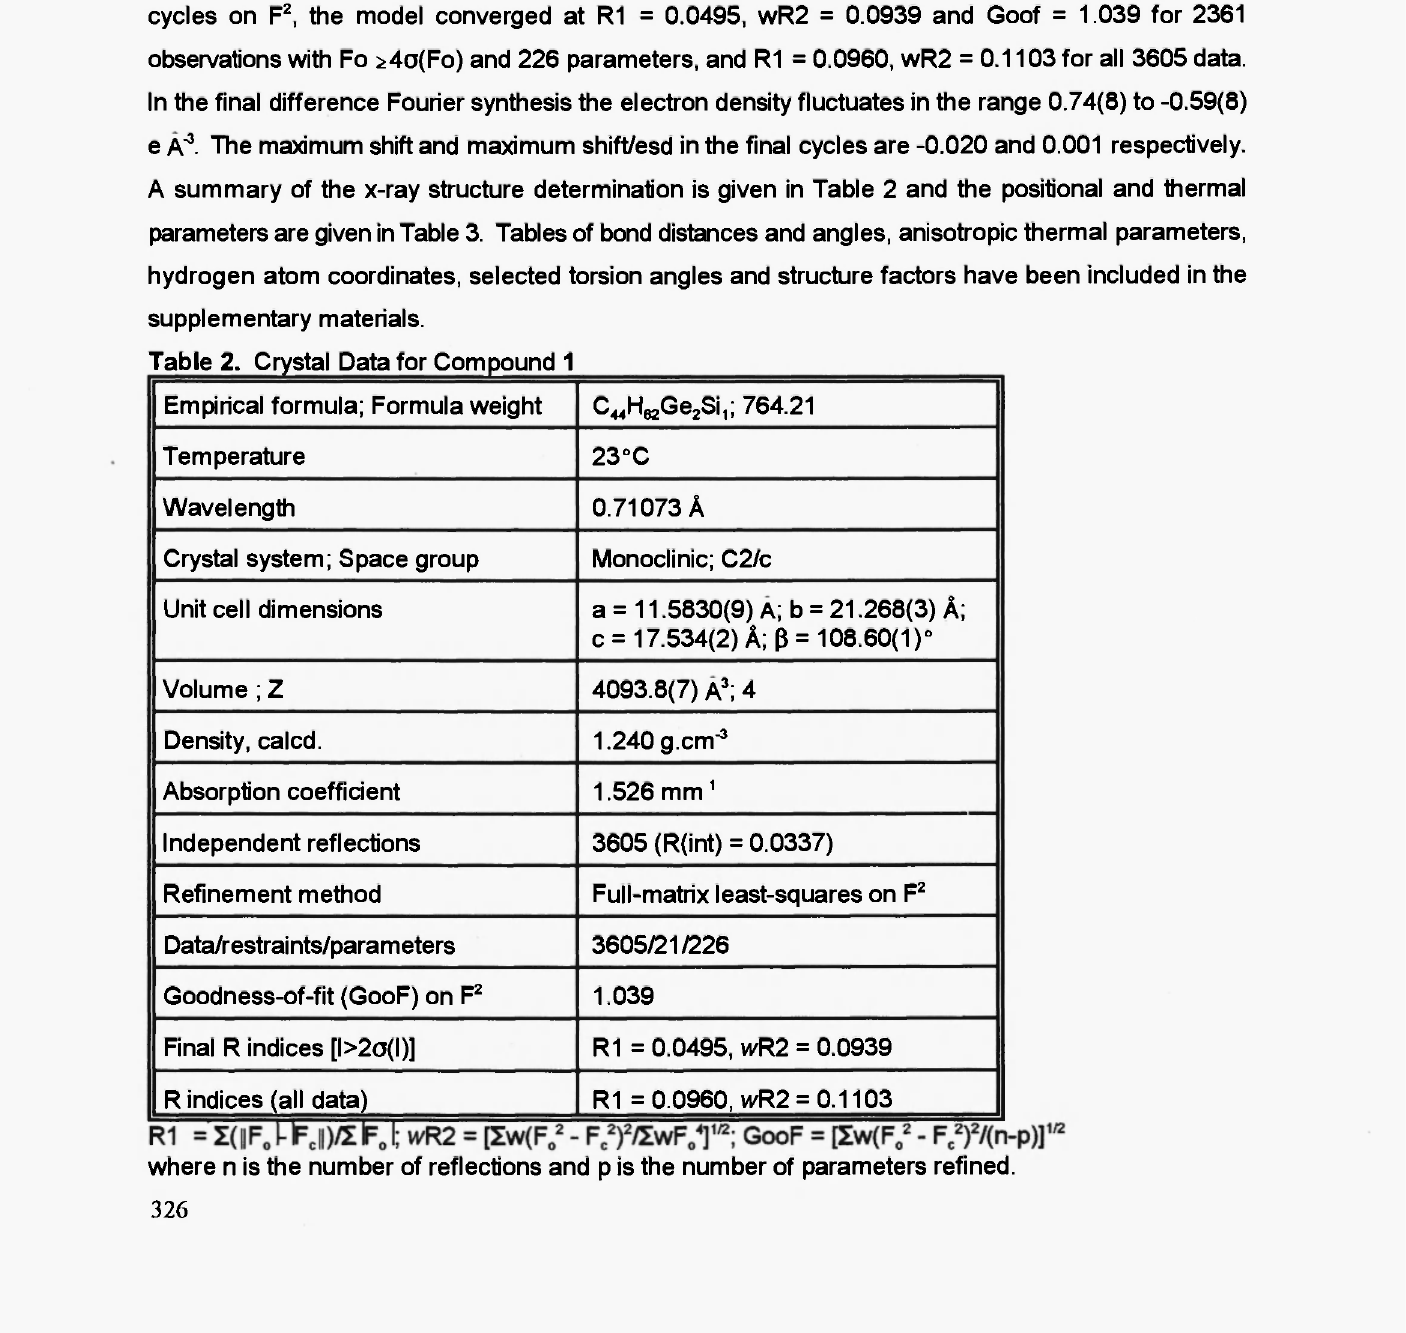
Table 2. Crystal Data for Compound